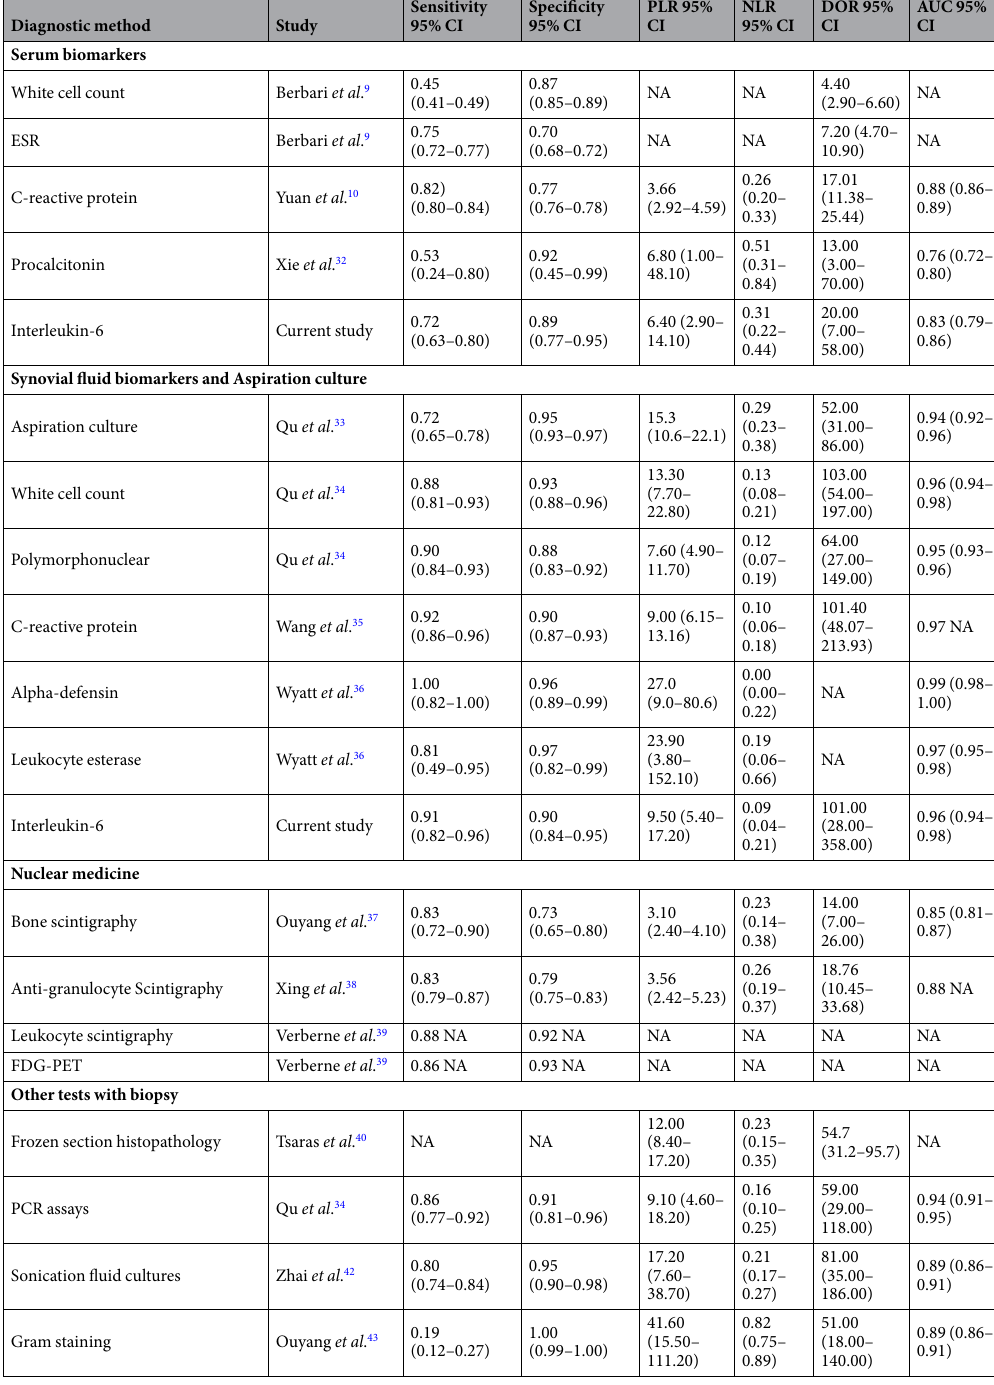
Table 3. Diagnostic value of different diagnostic method for the diagnosis of PJI. If one diagnostic method was reported by more than one meta-analyses, the most detailed and/or recent one was included in Table 3.